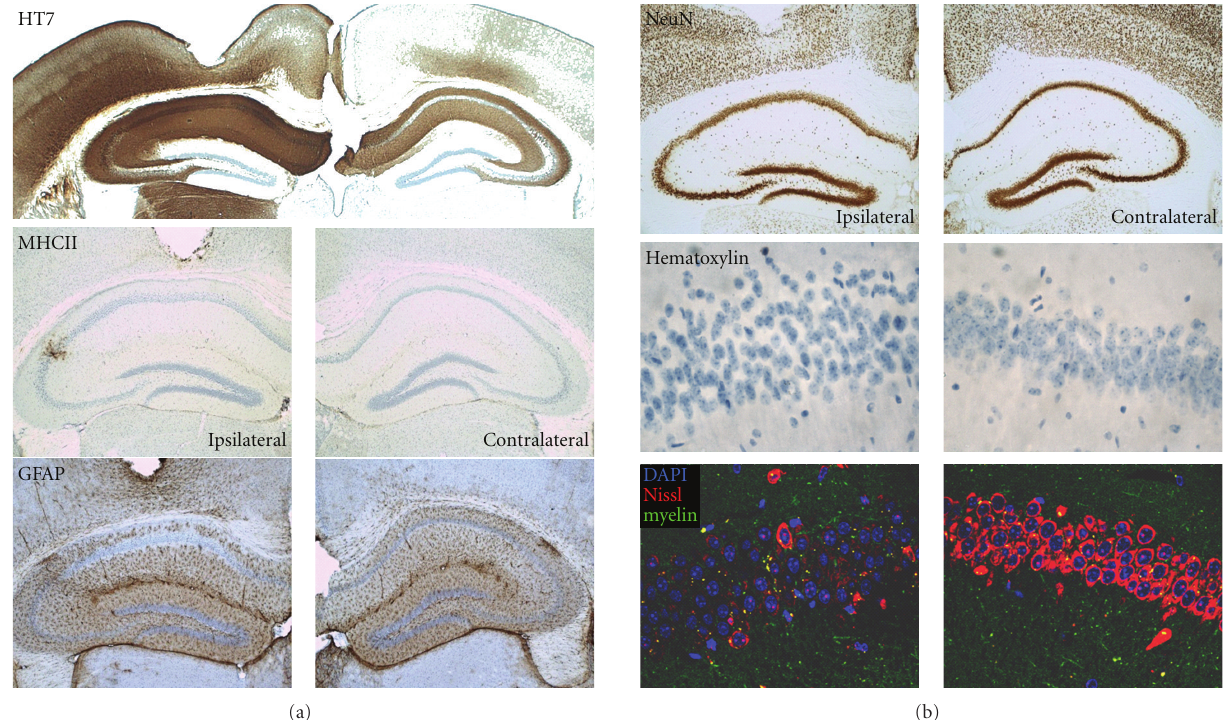
Figure 3: Tau-mediated toxicity depends on the microtubule binding domain. Intracerebral injection of AAV-Tau.255 (10e8 tu) into wild- type mice to express a truncated form of protein Tau devoid of the microtubule binding and C-terminal domains, did not cause appreciable neurodegeneration nor inflammation. Shown are immunohistochemical stainings at 3 months p.i. for human Tau (HT7), GFAP, and MHCII as indicators of astrogliosis and microgliosis, respectively [30]. Neurons expressing truncated protein Tau still maintain neuronal nuclei (NeuN) despite changes in nuclear morphology (hematoxylin) and in content of Nissl substance (lower